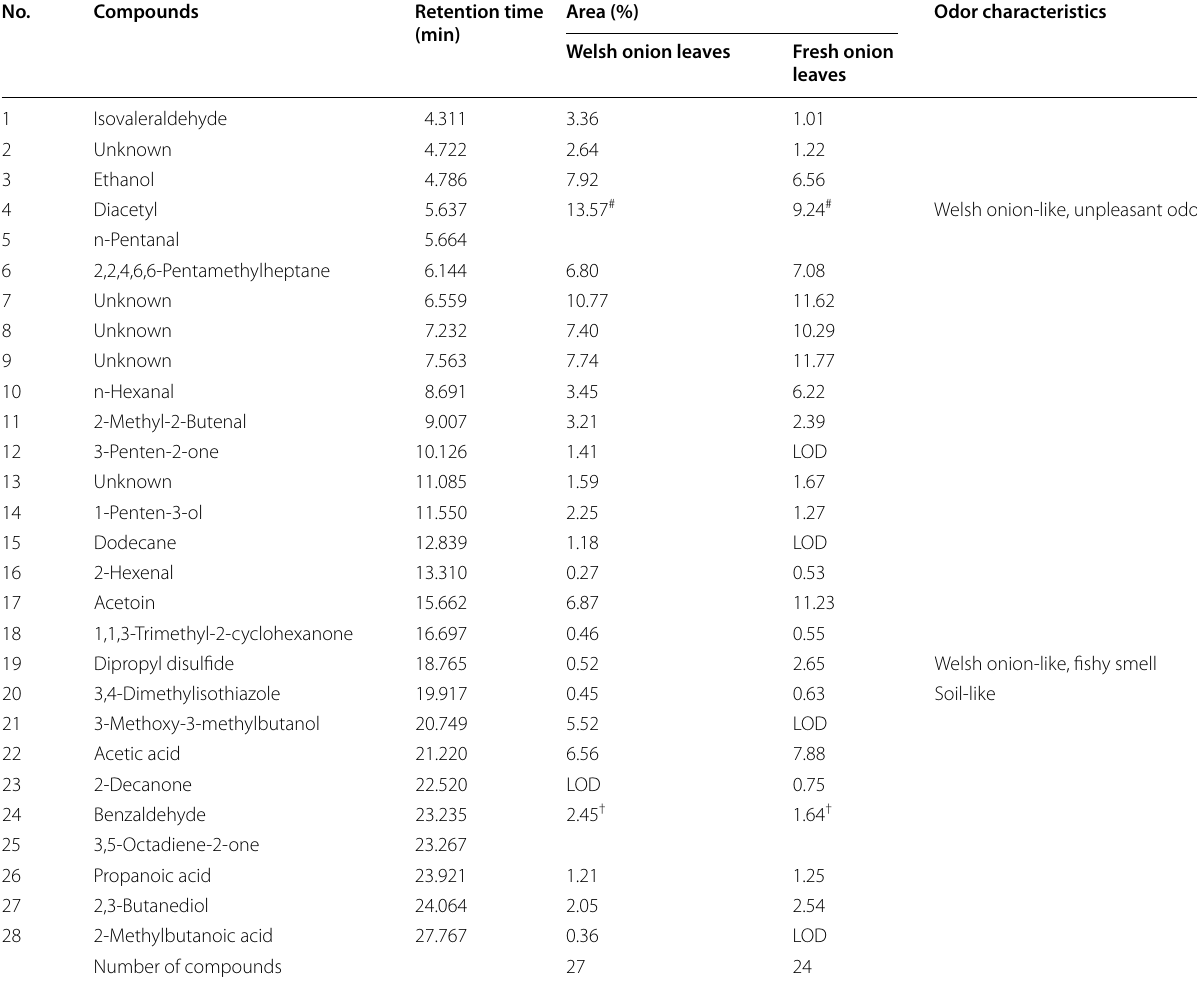
Table 3 Volatile compounds and odor characteristics in leaves of Welsh onion and fresh onion